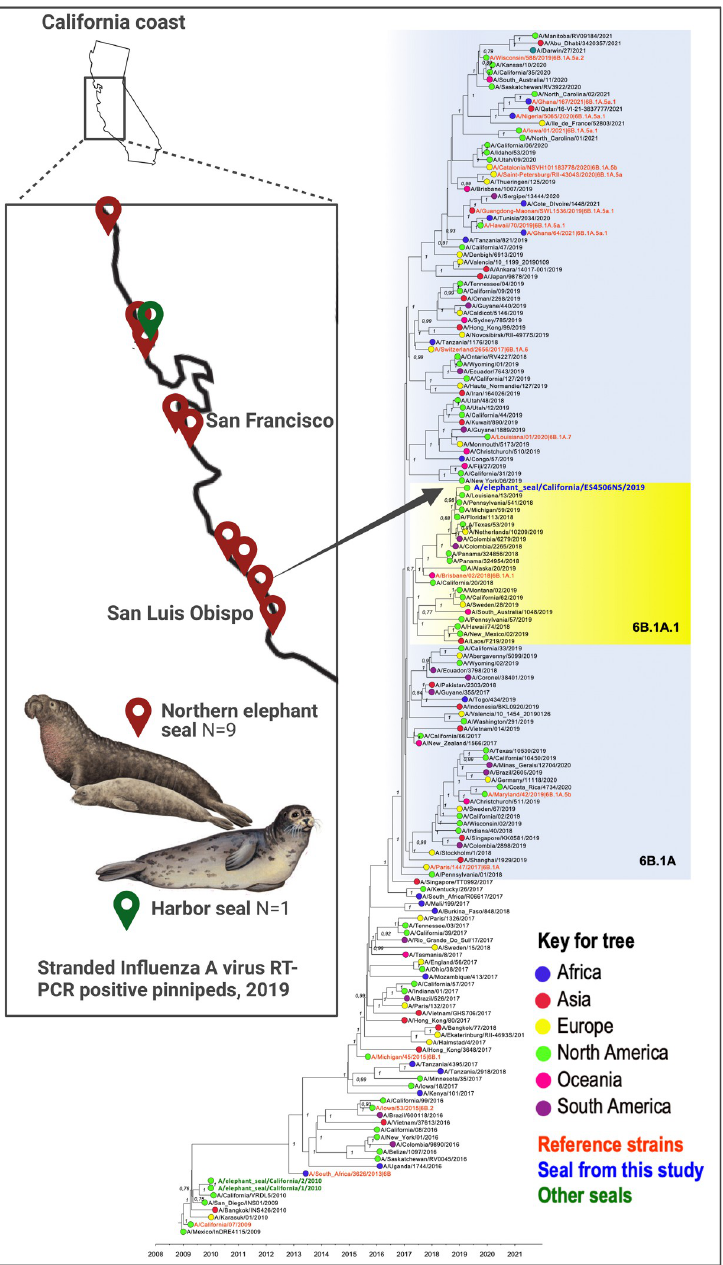
Fig 2. Influenza A virus RNA detections in marine mammals, California, 2019. Map shows locations of stranded marine mammals on California coasts that contained IAV RNA in nasal swabs. The tree is a time-scaled Maximum Clade Credibility phylogeny representing concatenated coding regions of all 8 A(H1N1)pdm09 IAV segments. A total of 165 representative pandemic H1N1 isolates sampled globally are included in the tree. Sequences in black text are from humans. The sequence in blue text shows the position of the IAV genome from a Northern elephant seal in this study. Green text shows sequences of IAV from other seals not part of this study that were sampled in 2010. The yellow shading shows clade 6B.1A/subclade 6B.1A.1 IAV, represented by the reference 2019–2020 vaccine virus A/Brisbane/ 02/2018. Bayesian posterior probability values > 70% are included for key nodes. The tree is rooted through the assumption of a strict molecular clock, such that tip times represent the time (year/month/day) of sampling. The source of the Northern elephant seal illustration was https://www.sciencedirect.com/topics/agricultural-and- biological-sciences/northern-elephant-seal. The figure was generated using Biorender.